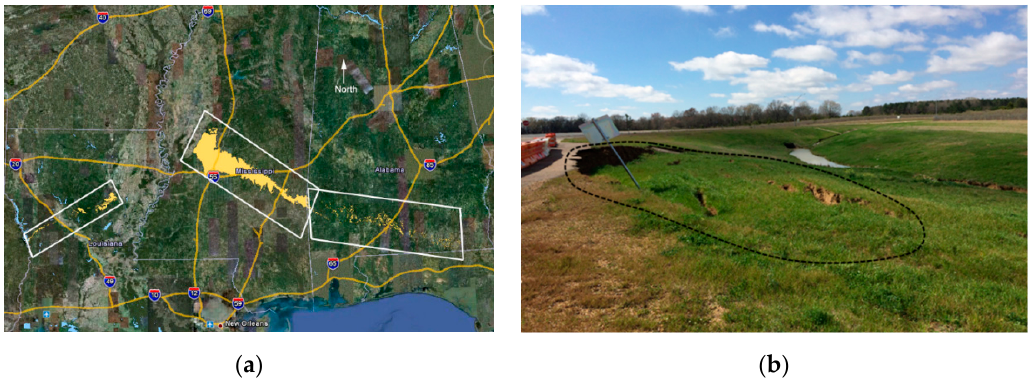
Figure 1. ( a ) Boundary boxes of the Jackson Formation, including Yazoo clay and its geological equivalents, in Mississippi, Alabama, and Louisiana (after USGS 2010). ( b ) Slope failure observed in Jackson, MS.